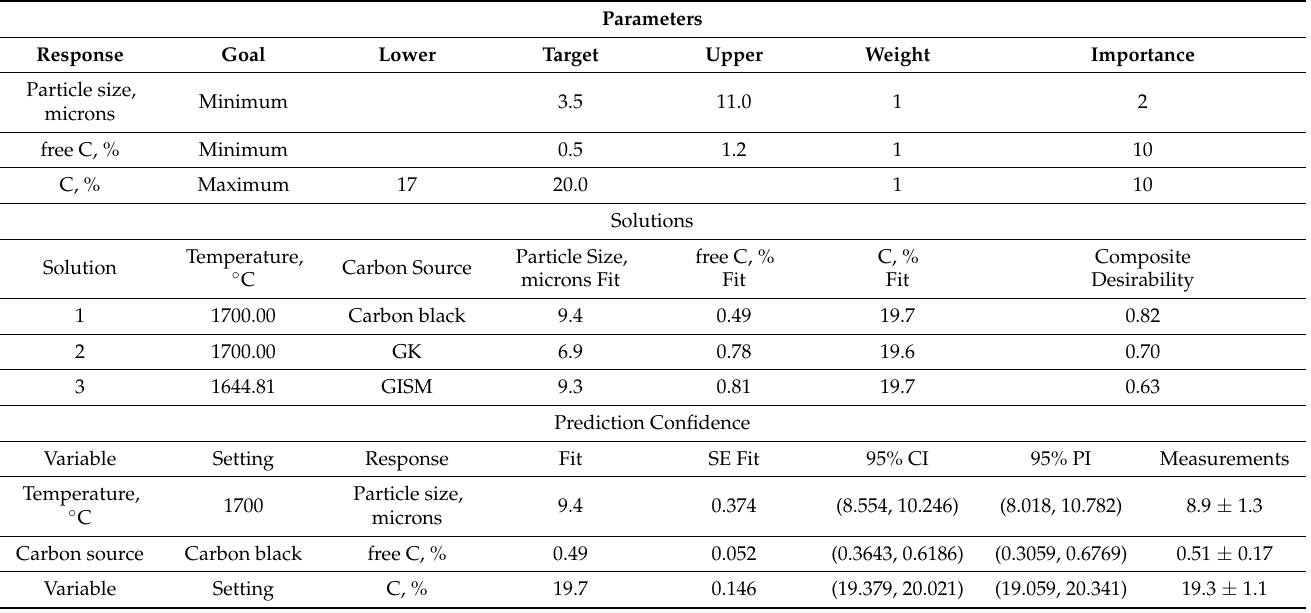
Table 1. Response optimization for the TiC carbidization process based on the developed regression model. SE—standard error, CI—confidence interval, PI—prediction